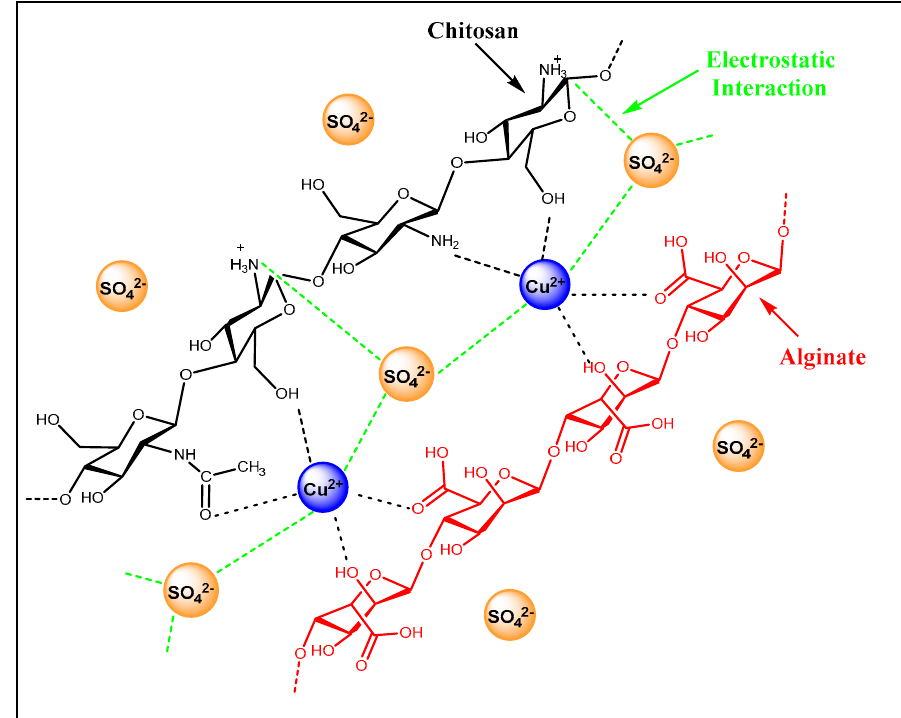
Figure 8. Proposed adsorption mechanism of SO 42 − anions by a ternary biopolymer composite that contains Cu(II).